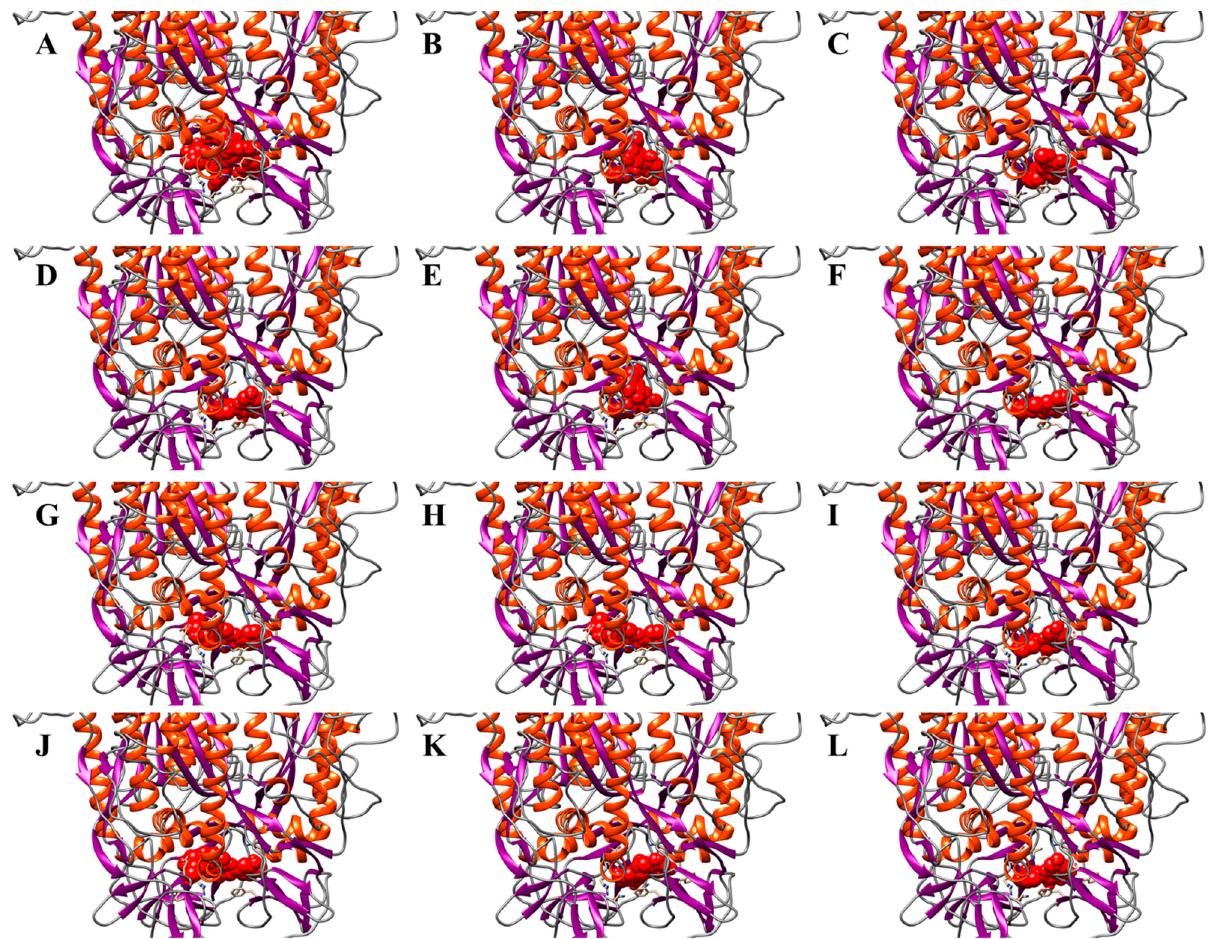
Figure 5. Molecular representation of the thirteen best complexes identified by docking. α -helices are represented as orange spirals, β -strands through violet arrows, while the compounds are shown as red spheres. ( A ) Complex between spike glycoprotein and Pentagalloyl glucose. ( B ) Complex between spike glycoprotein and Vitexin. ( C ) Complex between spike glycoprotein and 6-8-dihydroxy-7-methoxycoumarin. ( D ) Complex between spike glycoprotein and Quercetin. ( E ) Complex between spike glycoprotein and Taxifolin-3-glucoside. ( F ) Complex between spike glycoprotein and Isofraxoside. ( G ) Complex between spike glycoprotein and Isovitexin. ( H ) Complex between spike glycoprotein and Gallocatechin. ( I ) Complex between spike glycoprotein and Isoorientina. ( J ) Complex between spike glycoprotein and Epigallocatechin. ( K ) Complex between spike glycoprotein and Artelin. ( L ) Complex between the spike glycoprotein and the Magnolioside.